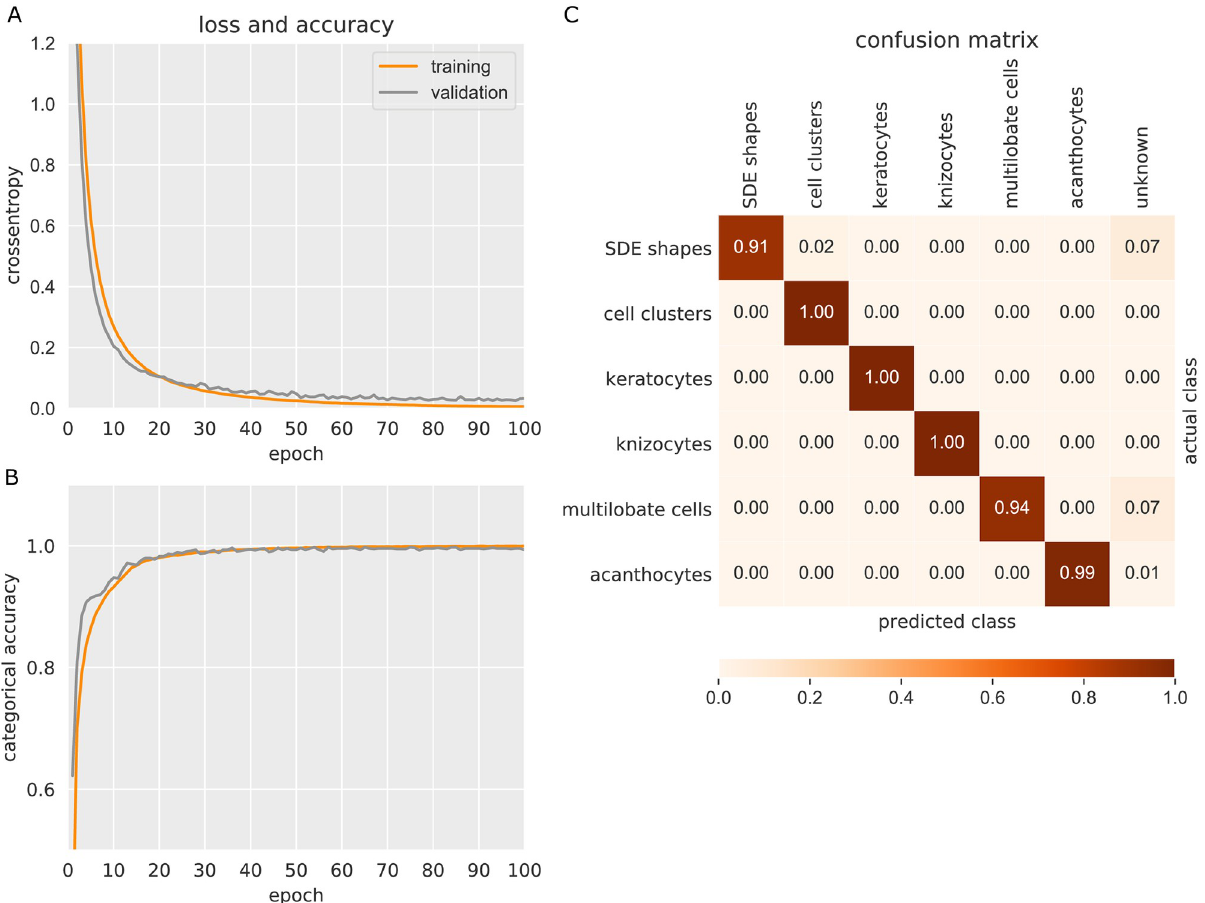
Fig 2. Training and validation loss and accuracy for the first-stage ANN. (A) During training, the employed loss function (crossentropy) was minimized throughout 100 epochs. (B) The categorical accuracy of cell classification for the training and validation sets converged close to 100%. The validation split was 20%. (C) The accuracy was further evaluated by means of a confusion matrix. “Predicted” versus “actual” (manually classified) cells demonstrate very good concordance, ranging from 91% to 100%.